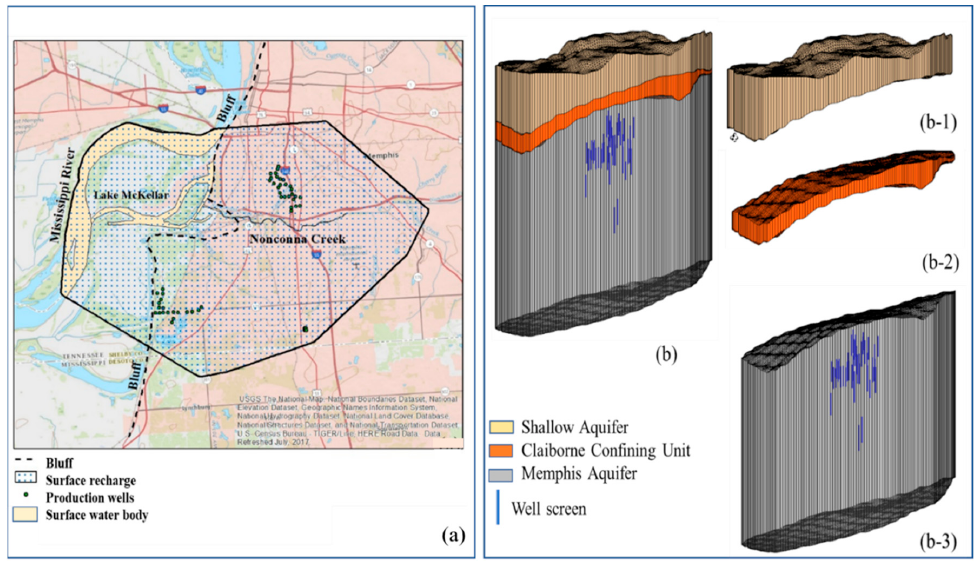
Figure 5. ( a ) A plan view of the conceptual model that includes a part of the Mississippi River, McKellar Lake, Nonconnah Creek, production wells, and surface recharge. ( b ) A side view of the conceptual model, and the location of production well screens. ( b-1 ), ( b-2 ), and ( b-3 ) separately show the Shallow aquifer, UCCU, and the Memphis aquifer,